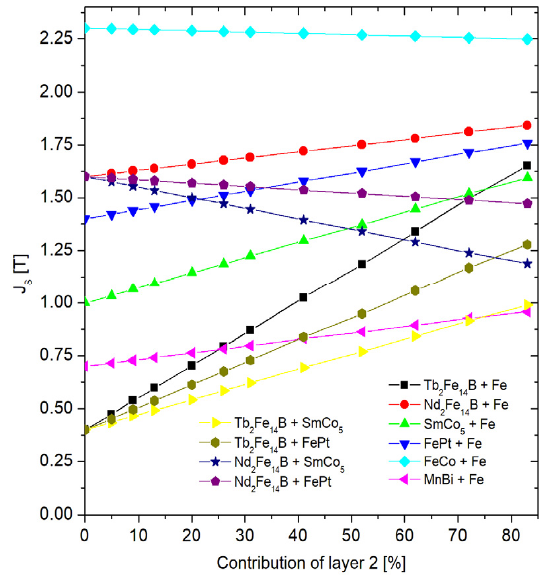
Figure 9. Saturation polarization in a function of the “layer 2” content.